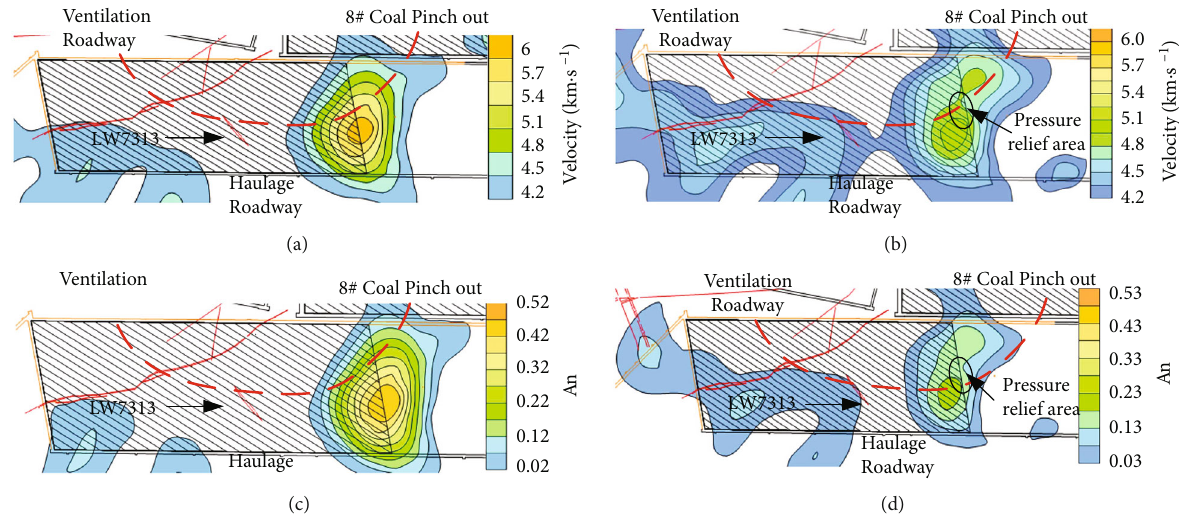
Figure 18: Seismic CT detection results of high stress area in inclined thick coal seam: (a) characteristics of wave velocity distribution before decompression (2020.09.20-2020.10.10); (b) characteristics of wave velocity distribution after decon fl iction (2020.10.10-2020.10.30); (c) distribution characteristics of wave speed anomaly index ( A ) before decompression; (d) distribution characteristics of wave speed n anomaly index ( A ) after decompression. n